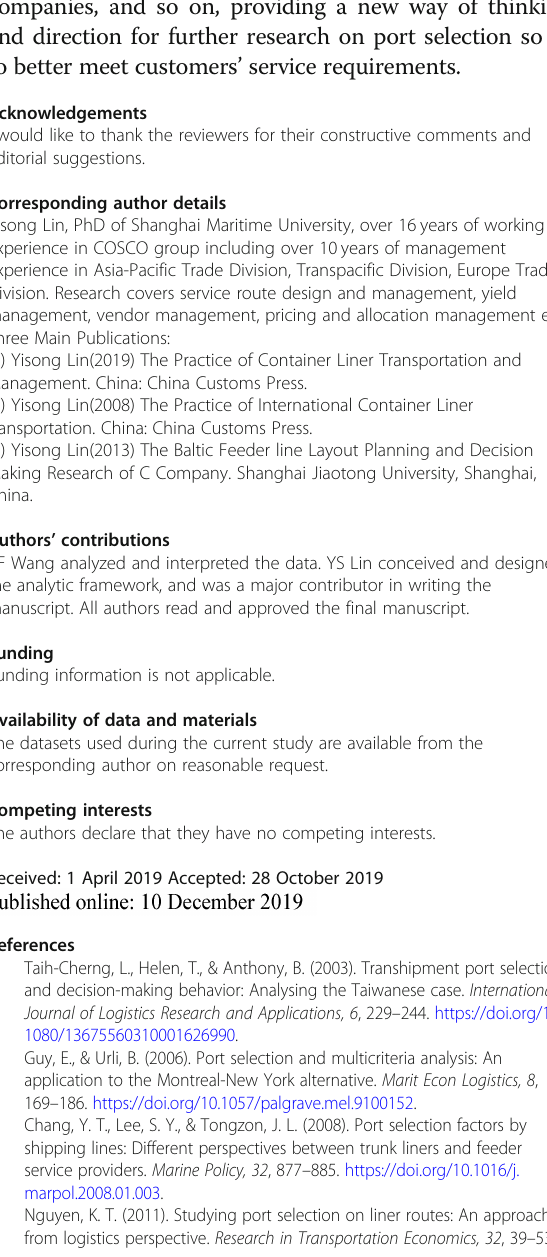
the main customer categories, including large-scale cargo owners, small- and medium-sized cargo owners, a global